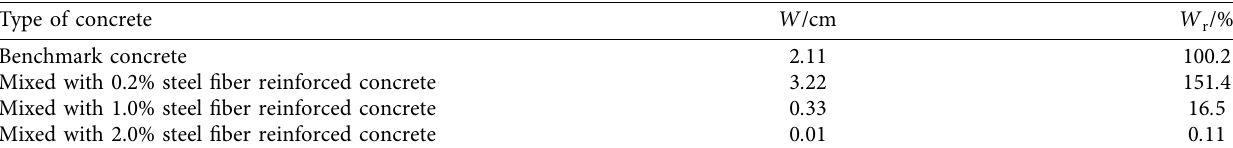
Table 3: Efect of steel fber content on drying shrinkage cracking in the early stage of hardening.